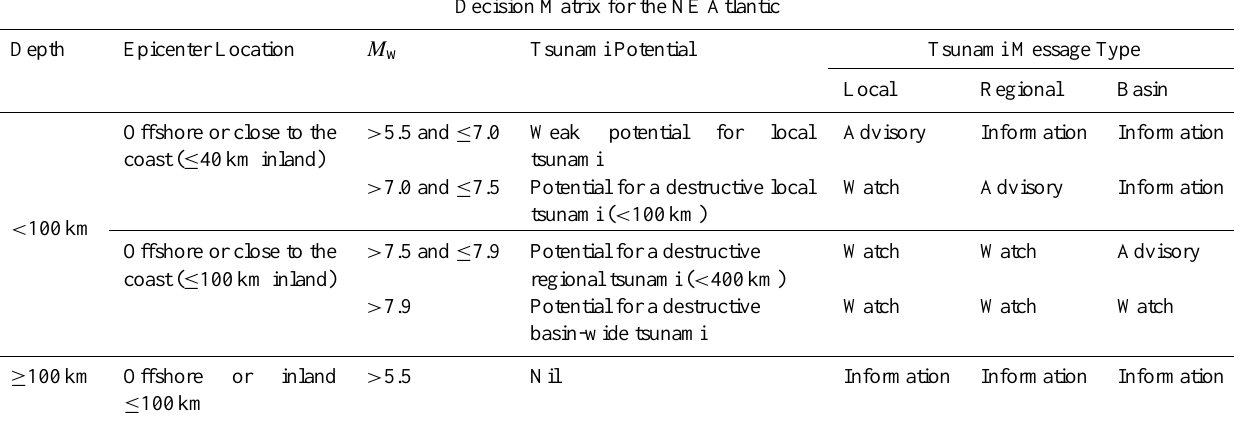
Table 1. Decision Matrix for the North-East Atlantic Ocean, proposed by the ICG/NEAMTWS in November 2010. Notice that no action is suggested when earthquakes with a depth less than 100km and with 5.5 < M w ≤ 7.5 are in the distance range between 40 and 100km, and for all earthquakes that are more than 100km inland.